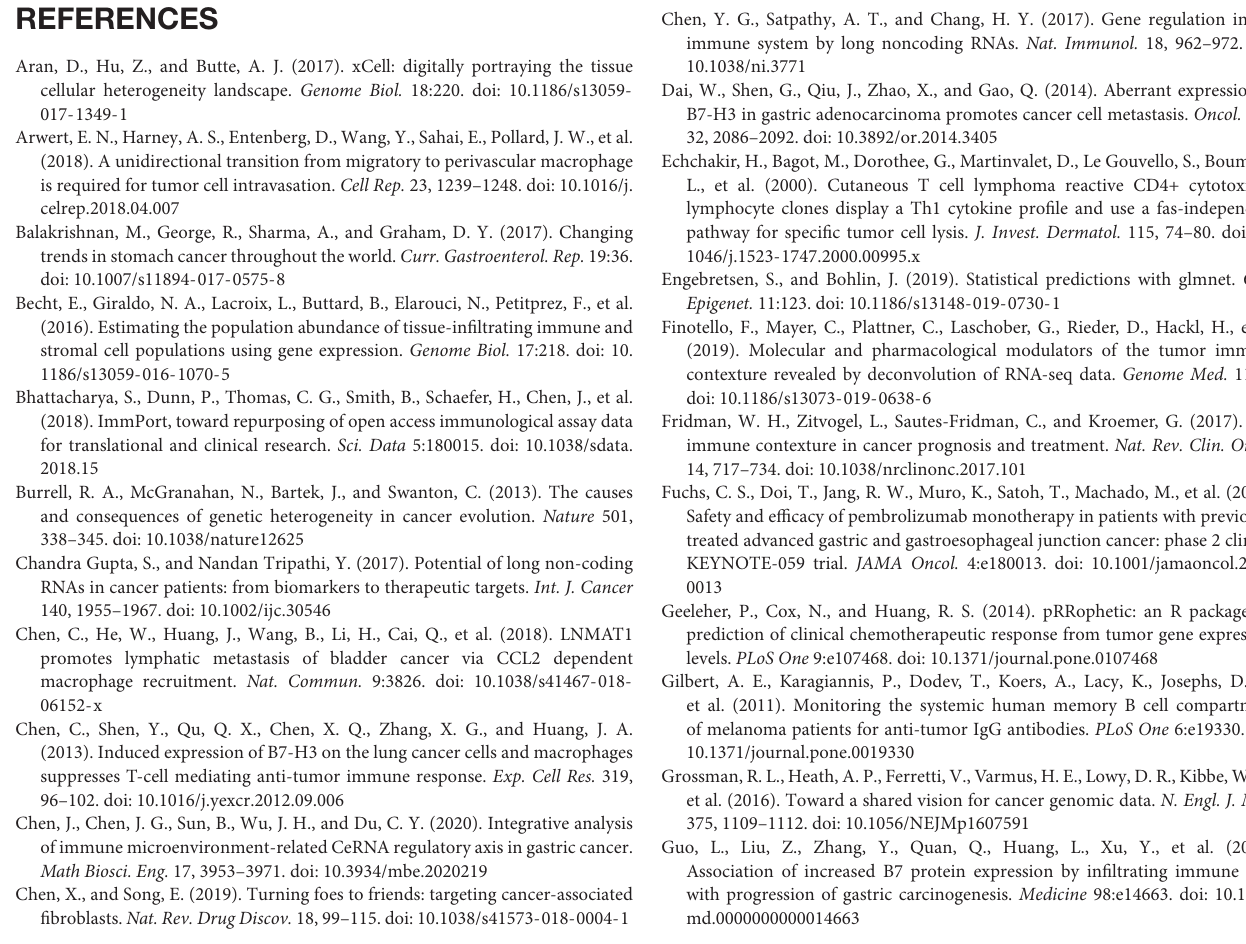
Supplementary Table 1 | DEIRlncRNAs in GC and paracancerous tissues (FDR < 0.05 and | log2 FC | > 2).